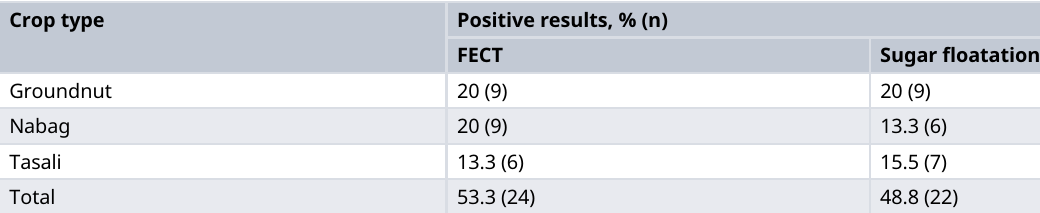
Table 4. Comparison between contaminated crop type and technique used.